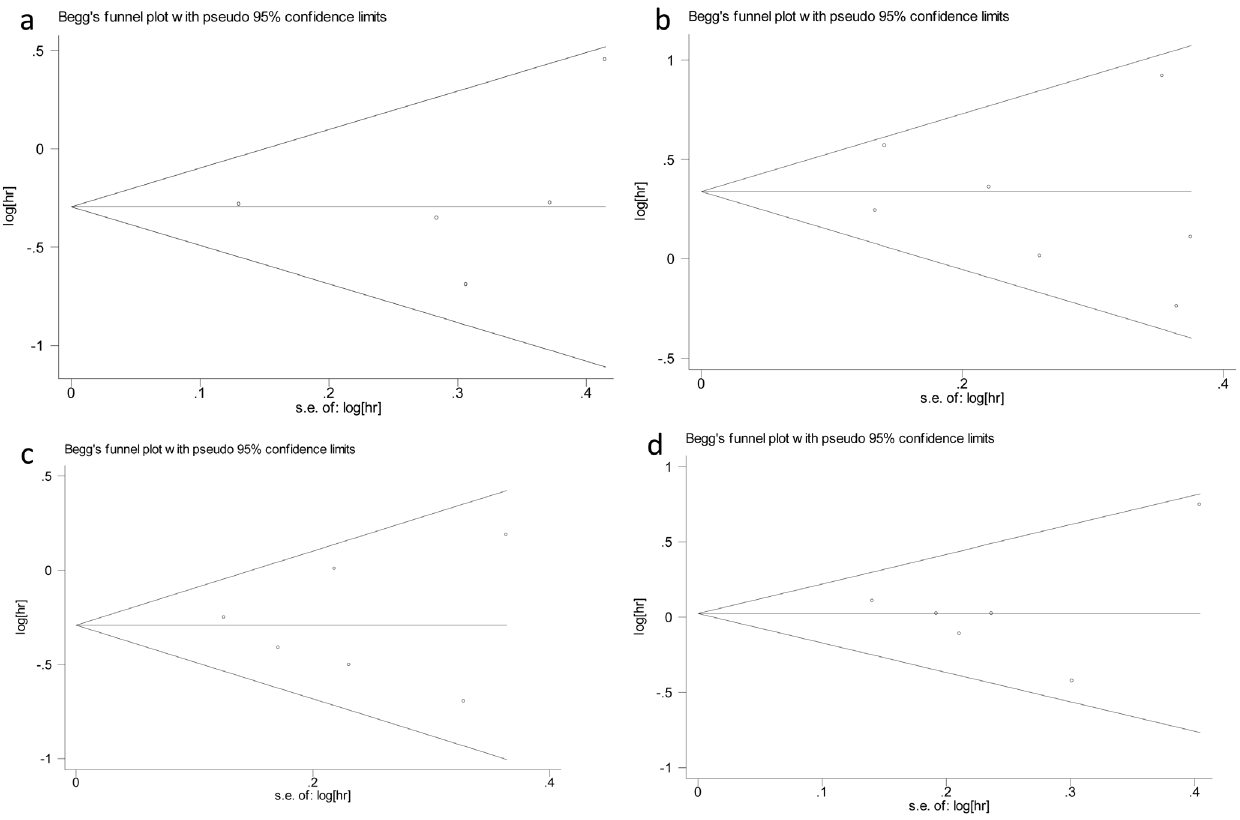
Figure 3. Funnel plots for the four genetic polymorphisms. Funnel plots of the publication bias for mir-146a in Dominant model(a), mir-196a2 in Recessive model(b), mir-149 in Dominant model(c) and mir-499 in AG vs AA(d).